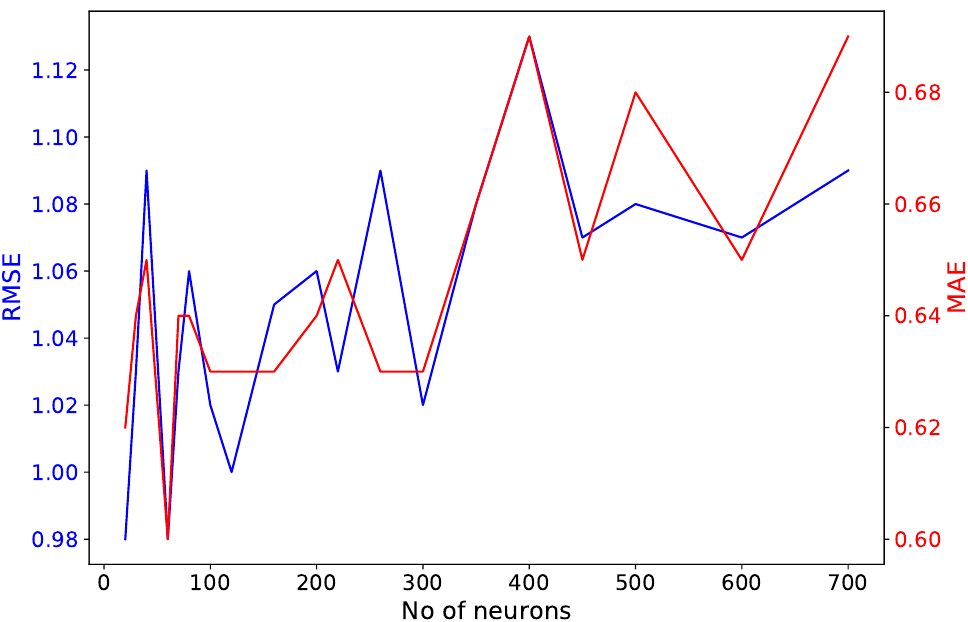
Figure 4. MAE and RMSE metrics estimated using the validation dataset within a grid search test under different numbers of long short-term memory (LSTM)